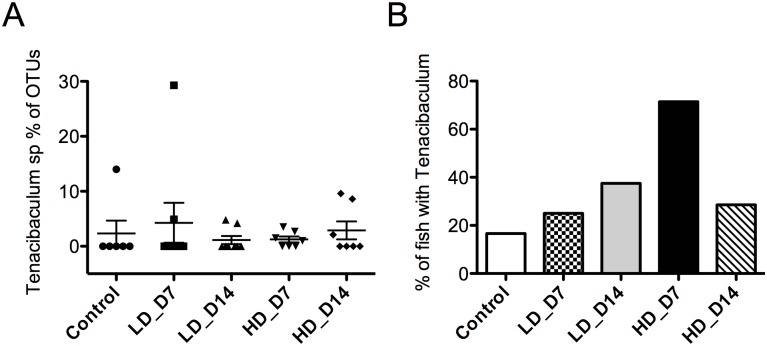
SAV3 infection results in increased abundance of Tenacibaculum sp. A) Percentage of total OTUs represented by Tenacibaculum sp. in control and SAV-infected groupsB) Percentage of fish containing Tenacibaculum sp. in their skin bacterial community in control and SAV-infected groups.LD_D7: low-dose infected day 7; LD_D14: low-dose infected day 14; HD_D7: high-dose infected day 7; HD_D14: high-dose infected day 14.